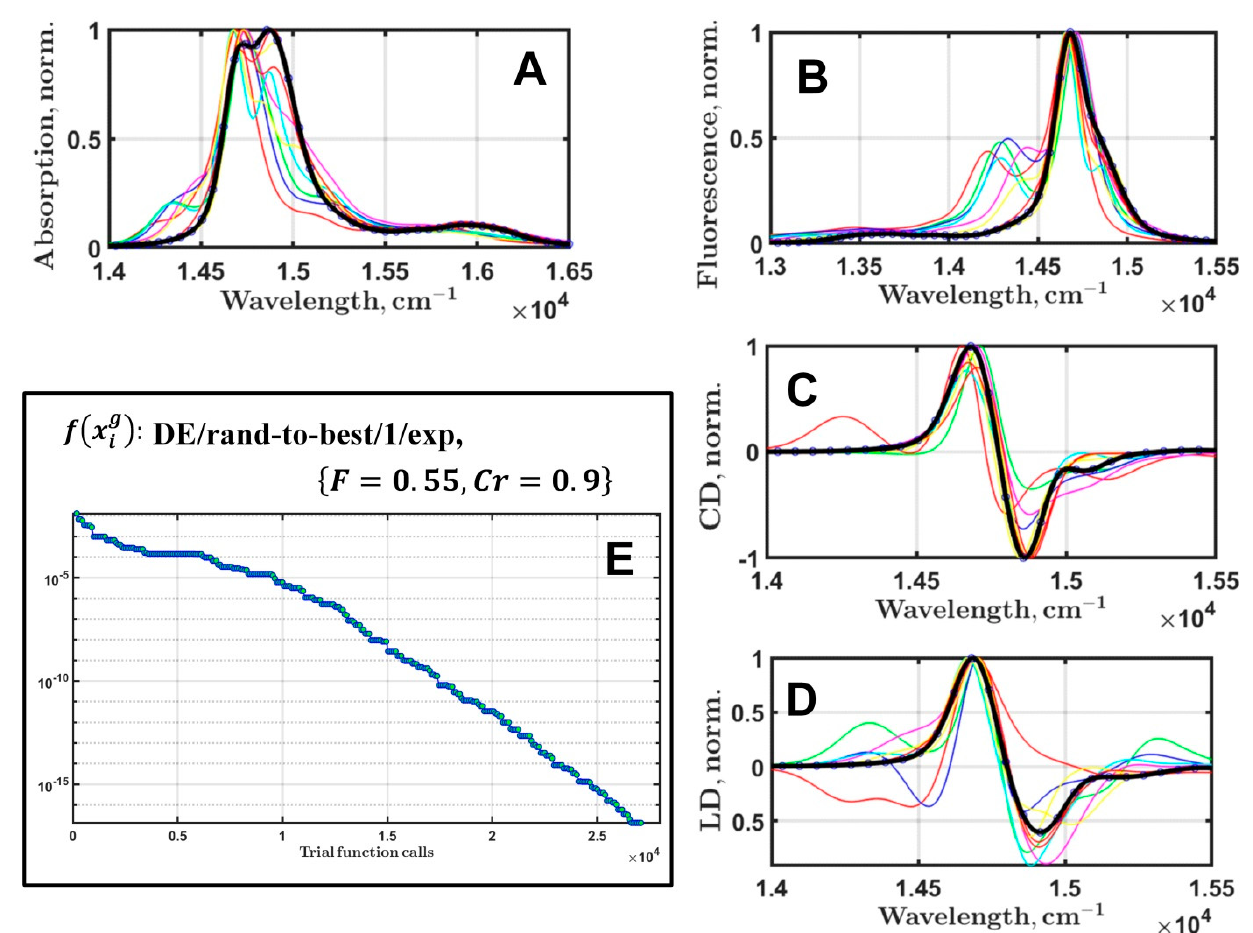
Figure 5. Results of the PSIIRC linear optical response fitting. Successful DE run. DE/rand-to-best/1/exp strategy. The best simulated spectra (black lines with circular markers) of absorption ( A ), steady-state fluorescence ( B ), circular ( C ), and linear ( D ) dichroism are shown. Color lines are the spectra found by DE after first 7 generations. Black thick lines are the target spectra. The objective function 𝑓(cid:3435)𝐱 (cid:3036)(cid:3034) (cid:3439) dependence on the number of the trial function (linear response simulation) calls ( E ).